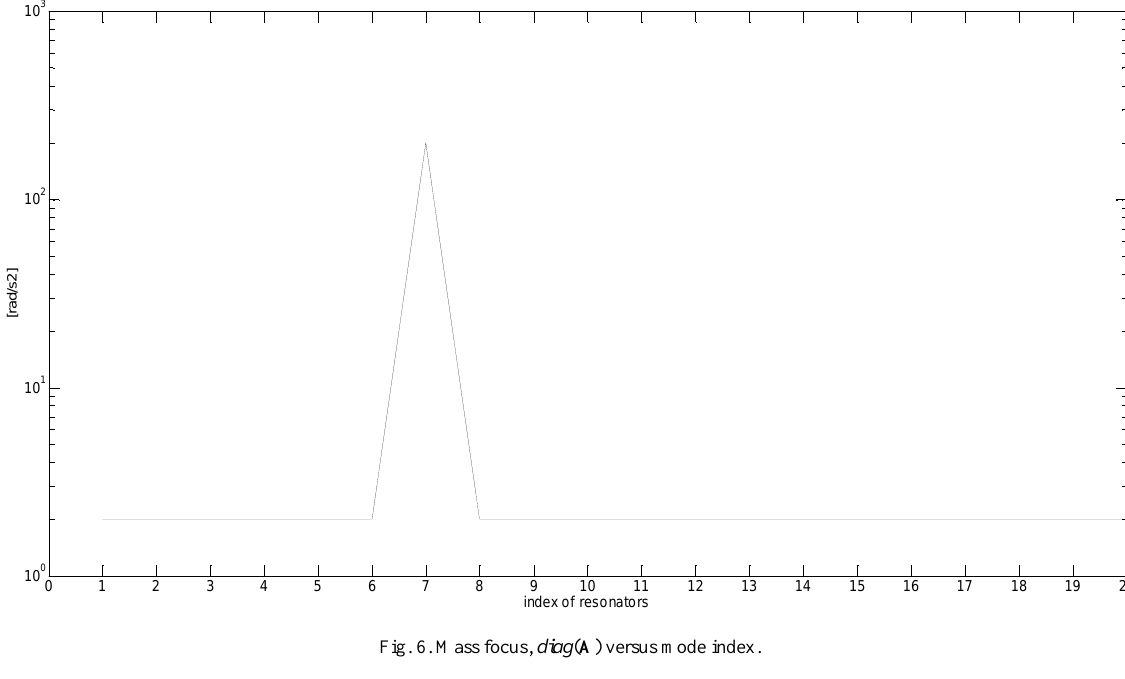
Fig. 6. Mass focus, diag ( A ) versus mode